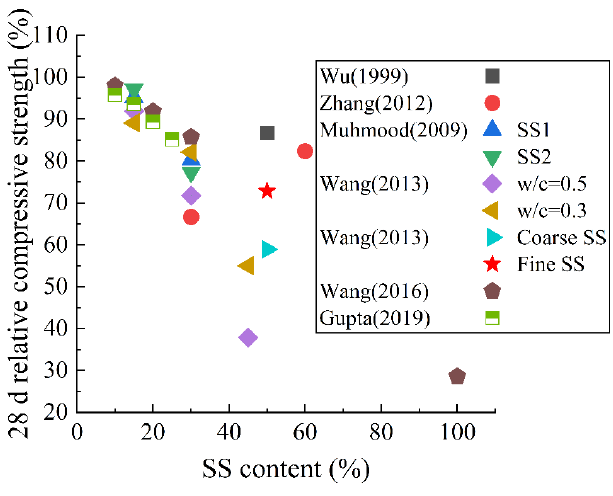
Figure 7. The 28 d relative compressive strength of hardened paste with SS as an SCM [12,54,80,82,102,103,107]. The relative compressive strength is the ratio of the compressive strength of composite paste containing metallurgical slag to that of the plain cement paste.